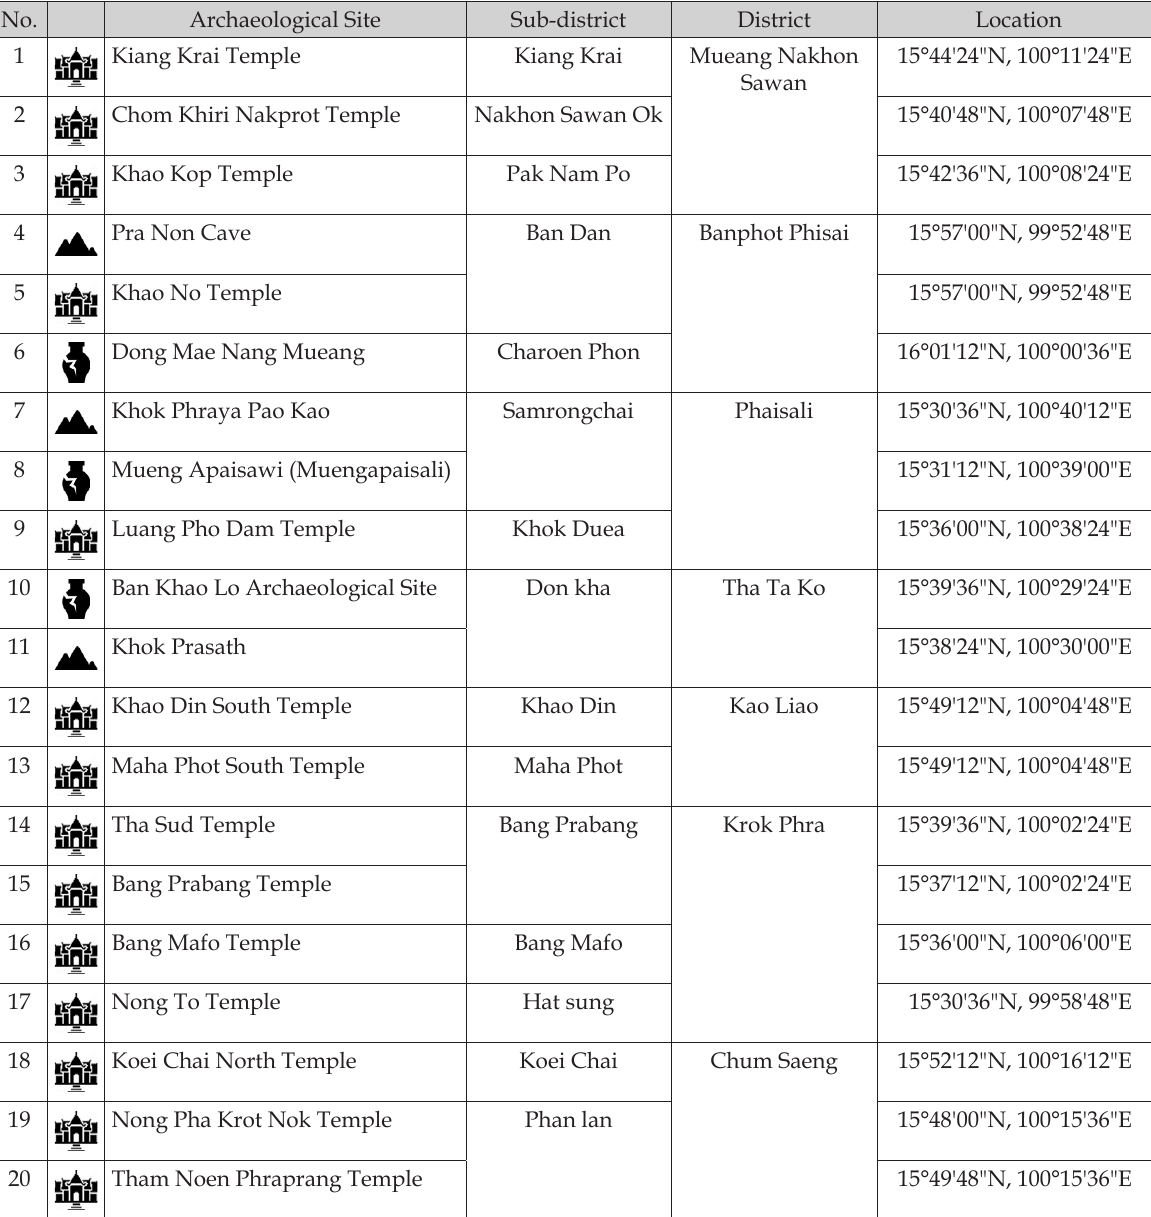
Table 1. Location of Archaeological Sites in Nakhon Sawan Province,